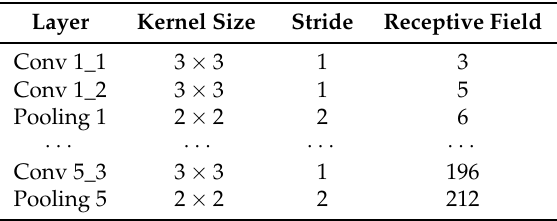
Table 1. Part of the VGG16 receptive